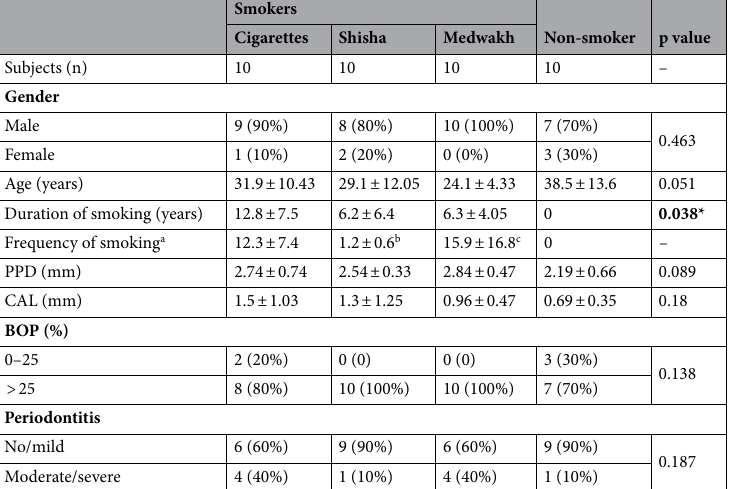
found in at least one sample from each group of smokers and non-smokers, except Lentisphaerae, which was absent from all smokers of cigarettes. Two Venn diagrams (Fig. 1) were generated to illustrate the shared gen- era and species among the microbial communities of the four study groups (regardless of relative abundance). We found 852 (74.3%) common genera and 1909 (51.8%) common species, representing the core microbiota community (Fig. 1, asterisk annotated). About 2% of total genera and 4.8–6.7% of total species were exclusively present in one study group, but these genera and species were detected at a very low abundance. Moreover, 17 (1.5%) genera and 69 (1.9%) species were exclusively found in all 3 smoker groups but were absent among non- smokers (encircled in Fig. 1A,B), but again, these genera and species were detected at a very low abundance (Supplementary Tables S1, S2).